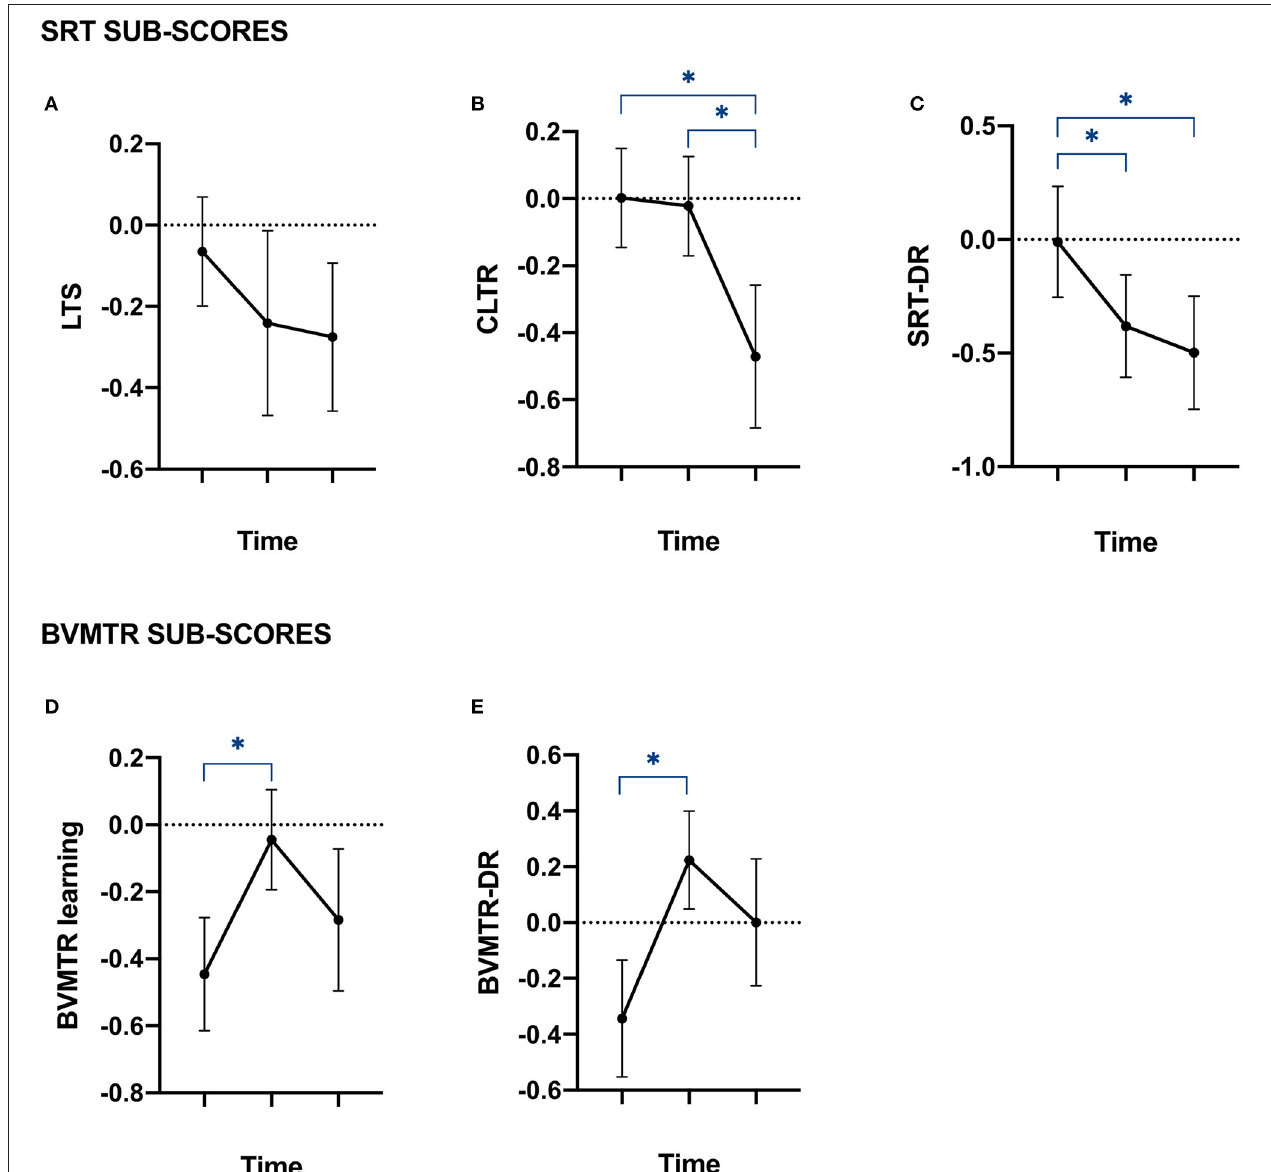
FIGURE 1 | Memory performances of patients at baseline, year 1 and year 5. Plots of patients’ Z -scores to the tests assessing episodic memory. Data are provided as mean with standard error of the mean. (A,B) plots represent the Z -scores of patients on each of the Selective Reminding Test (SRT) sub-items, assessing episodic verbal memory performances. (A) LTS, long-term storage; (B) CLTR, consistent long-term retrieval; and (C) SRT-DR = delay recall. (D,E) plots represent the Z -scores of patients on each of the Brief Visual Memory Test Revised (BVMTR) sub-items, assessing episodic visuospatial memory performances. (D) BVMTR = learning; and (E) BVMTR-DR = delayed recall. *Correspond to significant p -value after Bonferroni’s correction for multiple